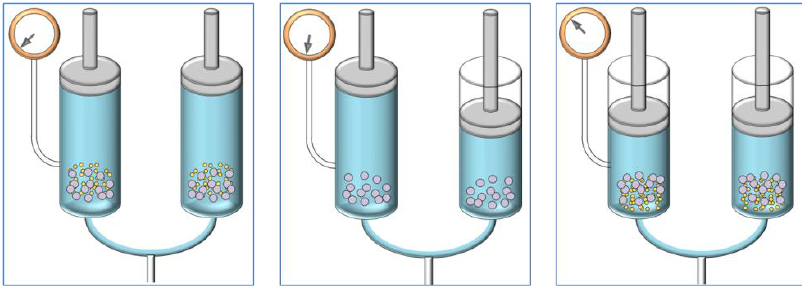
Figure 1. Schematic representation of the Naviglio extractor consisting of two extraction chambers connected via a conduit: the first two images show the dynamic phase, while the third image the static phase.